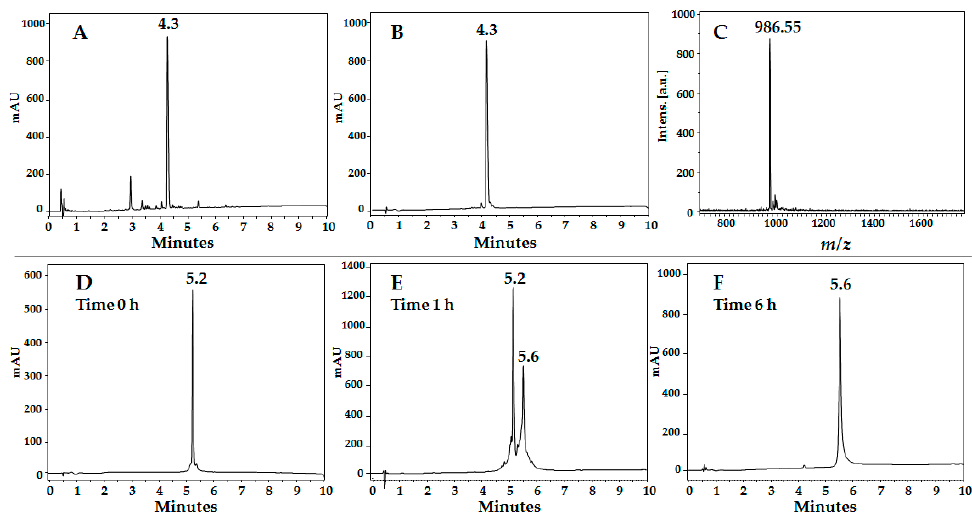
Figure 2. Reverse phase high performance liquid chromatography (RP-HPLC) analysis of LfcinB (20–25): crude ( A ) and purified ( B ) product. Purified LfcinB (20–25) matrix-assisted laser desorption/ ionization-time of flight mass spectrometry (MALDI-TOF) mass spectrum ( C ). Tetramer LfcinB (20–25) 4 formation by oxidation; RP-HPLC analysis of reaction mixture at different times: 0 h ( D : purified dimer precursor, t R 5.2 min); 1 h ( E ); and 6 h ( F : final tetramer product, t R 5.6 min).